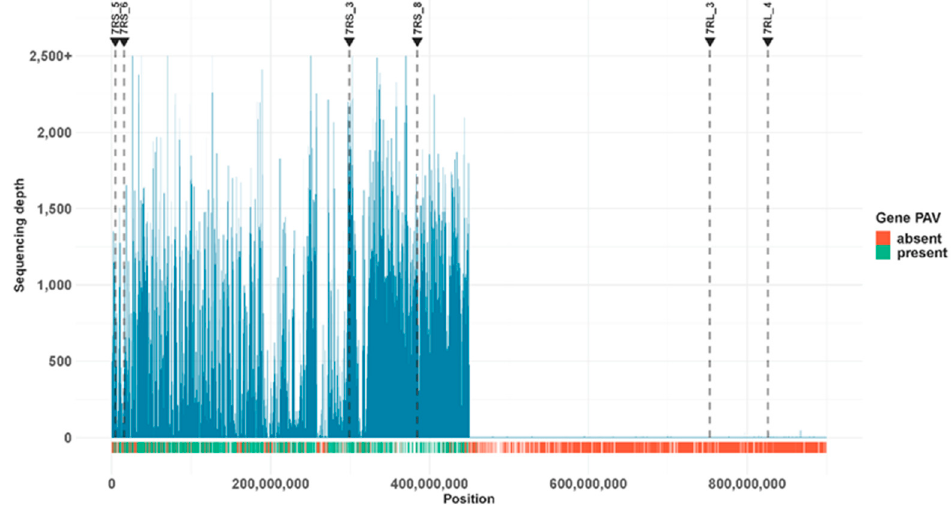
Figure 2. Chromosome arm 7RS Illumina DNA sequence reads were aligned to the Lo7 reference assembly. The median sequencing depth of 100 Kb windows is depicted in blue. Dashed lines indicate the chromosome arm PLUG marker alignment positions. Gene PAV is indicated as red (absent) and green (present) segments.